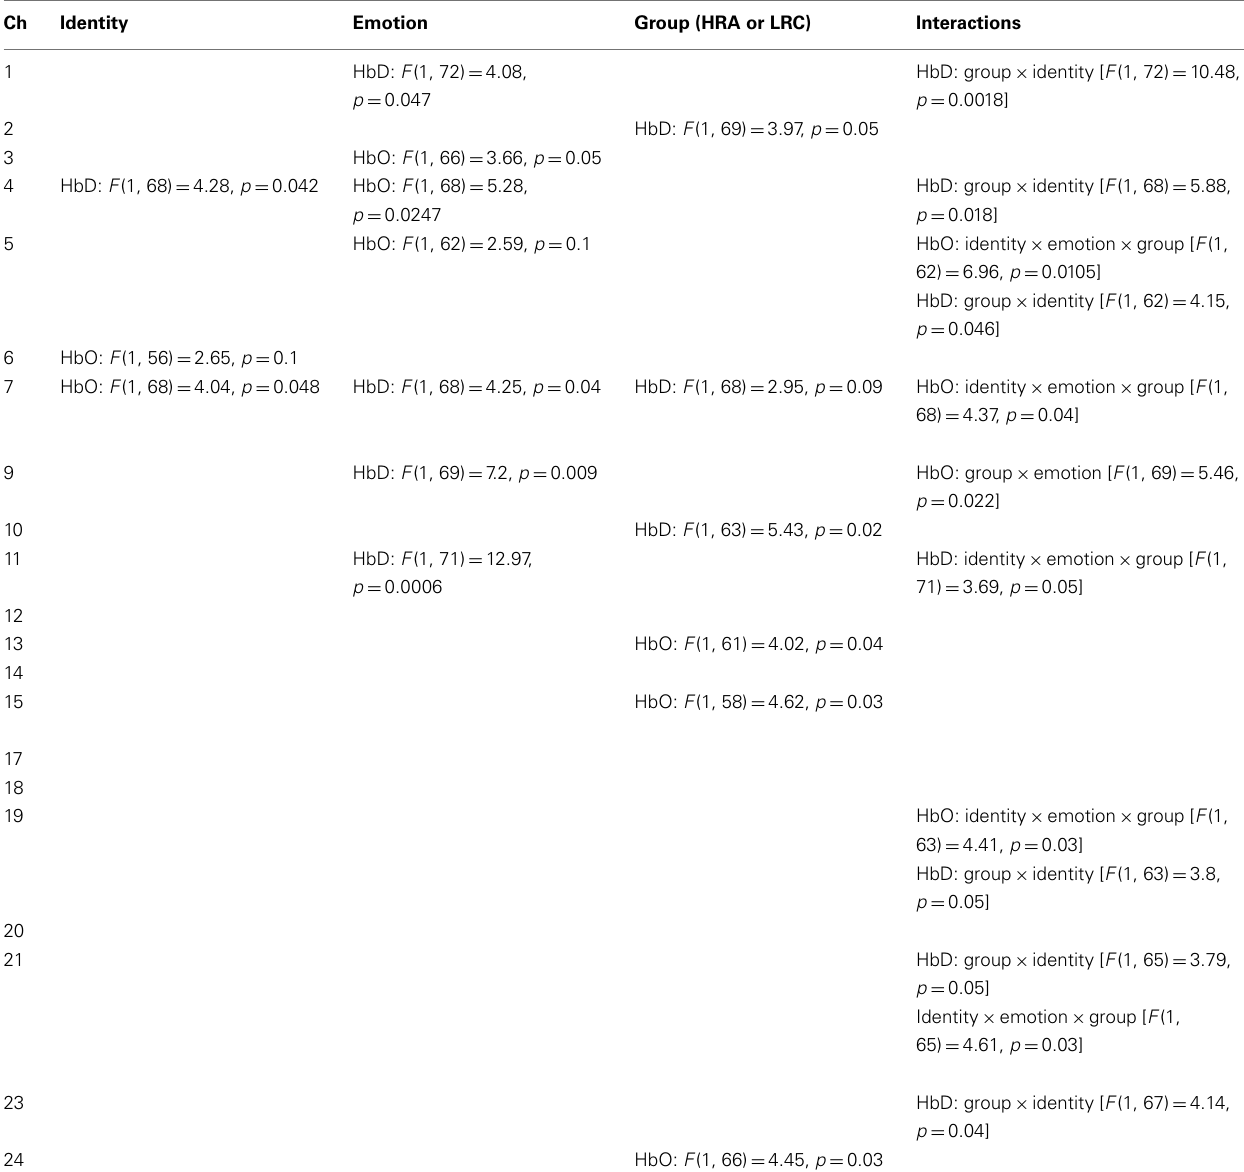
TableA1 | Statistical results of face identity × emotion ×